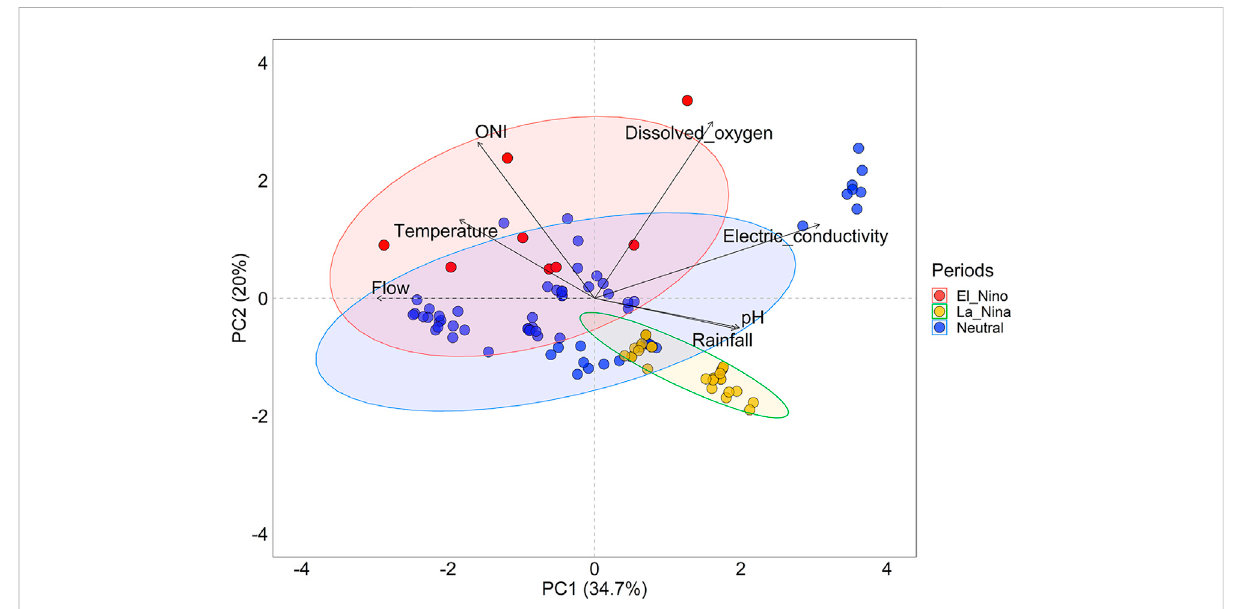
FIGURE 2 PCA analysis among variables environmental in the three sampled periods (neutral, La Niña, and El Niño) during the rising water in the Lower Amazon.